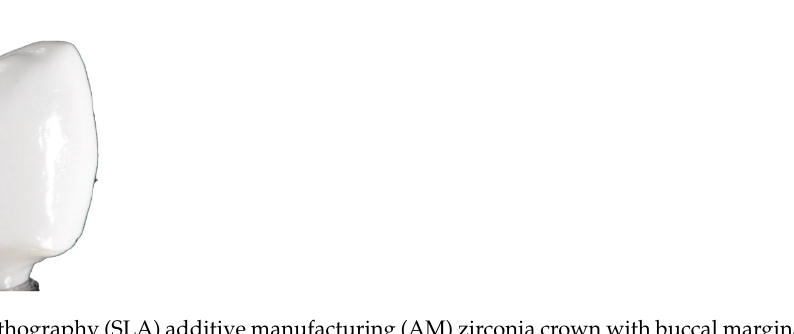
Figure 3. Stereolithography (SLA) additive manufacturing (AM) zirconia crown with buccal marginal defects.